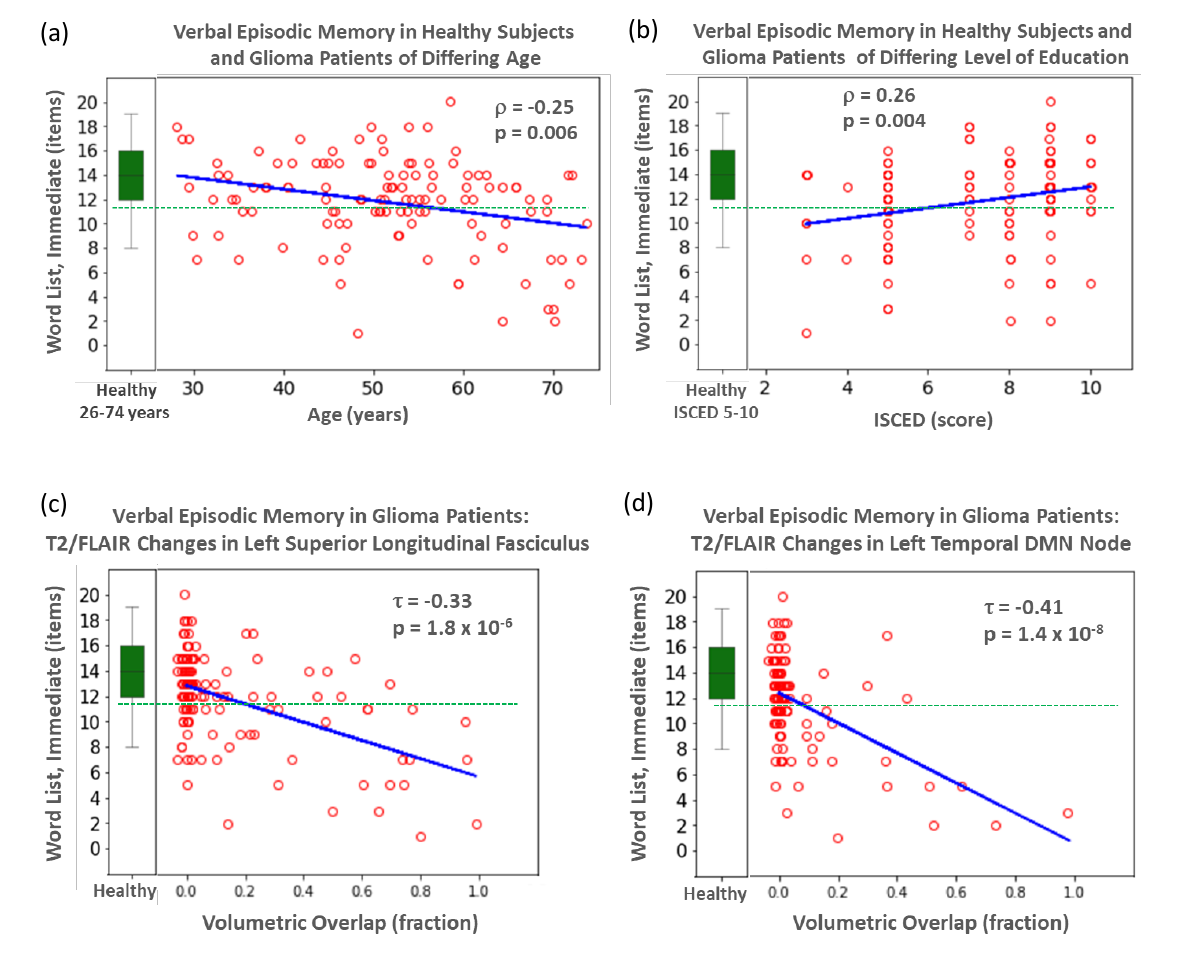
Figure 2. Correlation analysis for test scores of verbal episodic memory in WHO Grade III/IV glioma patients ( n = 121, red circles) with respect to age ( a ), education level ( b ), and the affection of selected atlas-derived tracts (left superior longitudinal fasciculus, ( c ) or resting-state functional nodes (left temporal DMN node, ( d ). τ : Kendall-tau-b correlation coefficient. ρ : Spearman’s rank correlation coefficient. A small jitter was added to the volumetric overlap in order to prevent overplotting. In addition, the calculated line for linear regression is depicted in blue. For reference, the distribution of scores in healthy subjects is shown as a boxplot (green). Patients were assumed to be affected by clinically relevant cognitive deficits if they fell below a threshold (defined as 1.5 standard deviations below the mean) based on the healthy subjects (green dashed